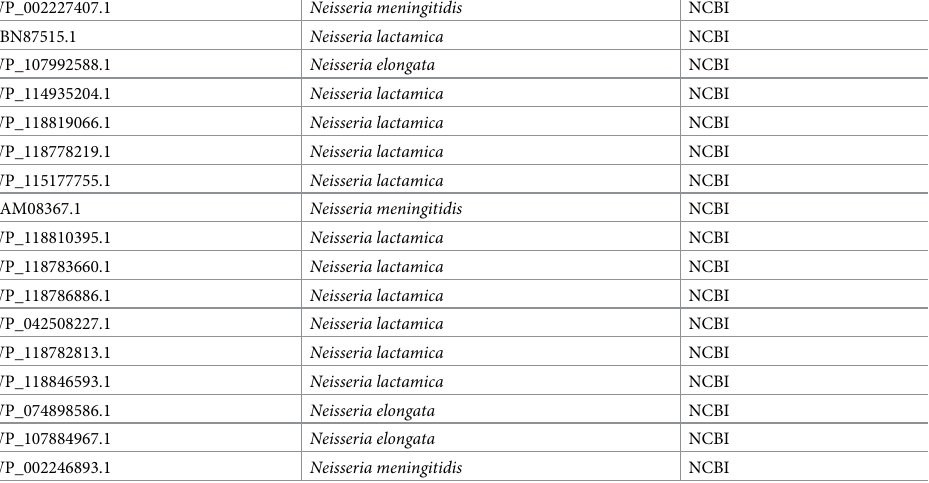
S1 Fig. Zn KO S100A7 does not bind zinc. Isothermal titration calorimetry was used to char- acterize the binding of zinc by wild type S100A7 (blue trace) and the mutant (red trace) designed to have substantially reduced affinity for zinc (S100A7 Zn KO). A clear binding iso- therm is observed for the wild type protein (blue trace) and no heat change for the mutant (red trace). These results indicate the zinc affinity of wild type S100A7 (blue trace) is in the nM range, whereas S100A7 Zn KO does not bind zinc with any appreciable affinity. S2 Fig. Integral western blot corresponding to data presented in Fig 3. As our research uti- lizes a novel α -TdfJ antibody, we show here an uncropped western blot utilized in the genera- tion of Fig 3 of this manuscript. This figure is intended to demonstrate that this antibody is specific for TdfJ and provides little background signal, making it appropriate for the applica- tions demonstrated herein. The signals shown represent TdfJ at the correct MW: 86 kDa. Pri- mary dilution used in this blot was 1:200 in Tris-buffered saline, and secondary antibodies were α -guinea pig conjugated to HRP used at